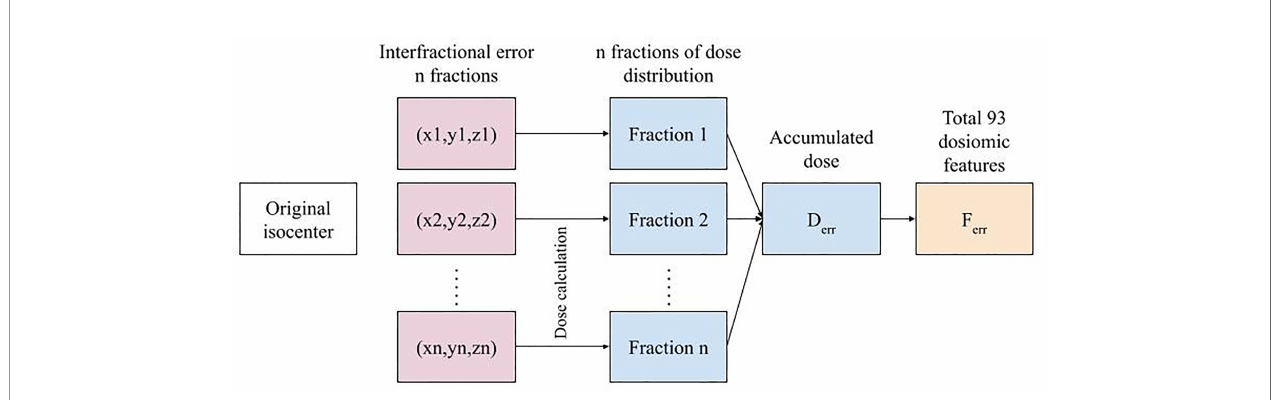
FIGURE 2 | The overall error simulation procedure for n fractions to feature extraction for a single treatment plan.